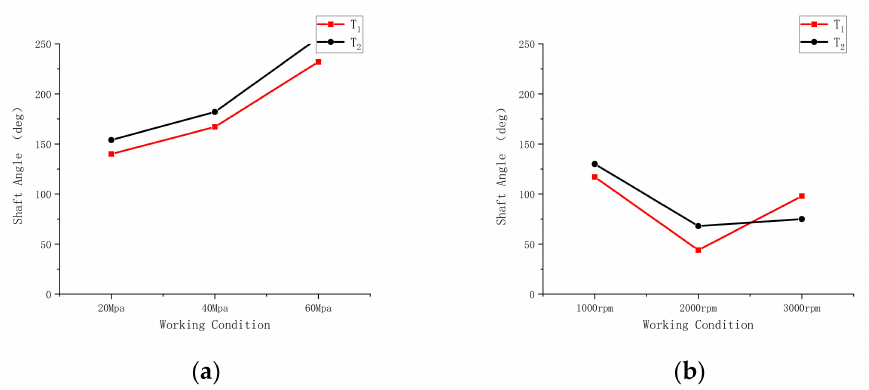
Figure 9. Eigenvalue comparison diagram: ( a ) Comparison of eigenvalues under di ff erent loads; ( b ) Comparison of eigenvalues under di ff erent rotating